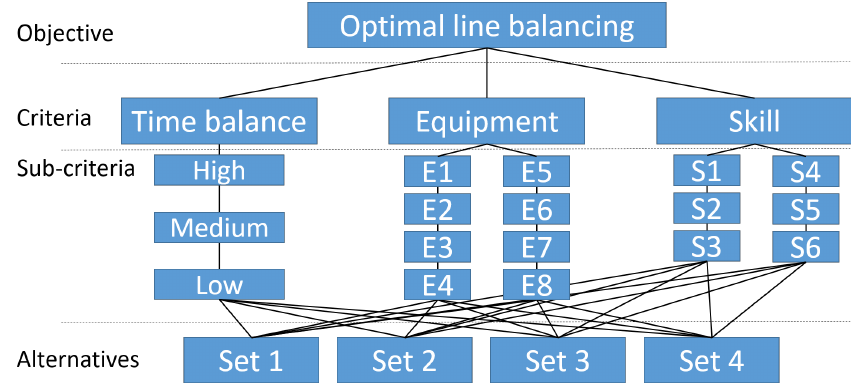
Figure 6. Analytic hierarchy process (AHP) used to solve a decision